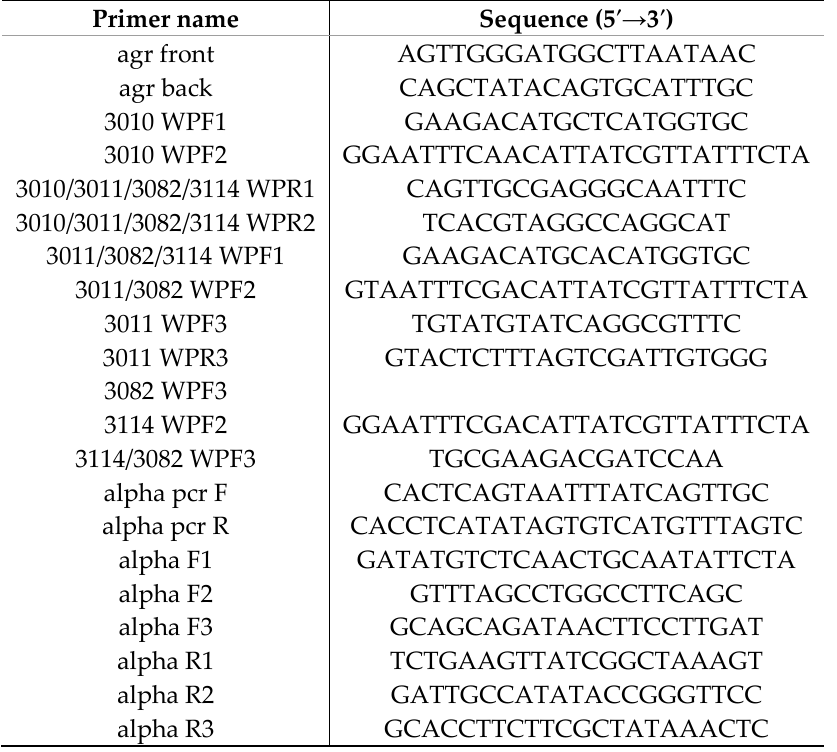
Table 1. Primers used in this